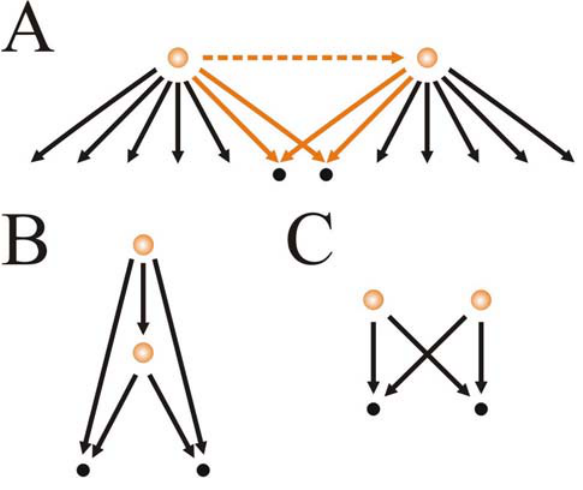
Figure 5. Motif assembly by random overlap of large regulons. (A) In this example a couple of hubs shares two target (corregulated) operons. As hubs may interact or not (dashed line), these coregulations lead to the assembly of aggregated FFLs (B) or bi-fan motifs (C).